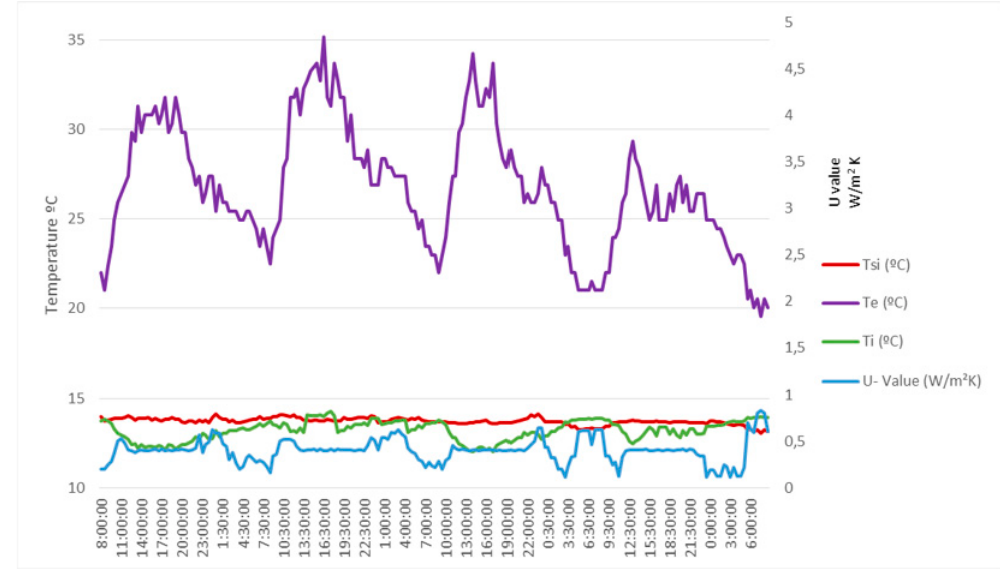
Figure 12. Measures taken with the developed U-Value metre after the energy retrofitting.